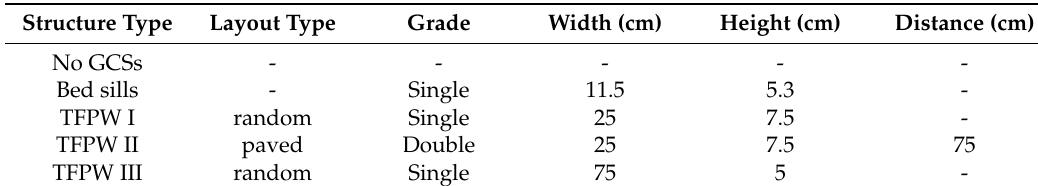
Table 1. Structural characteristics.